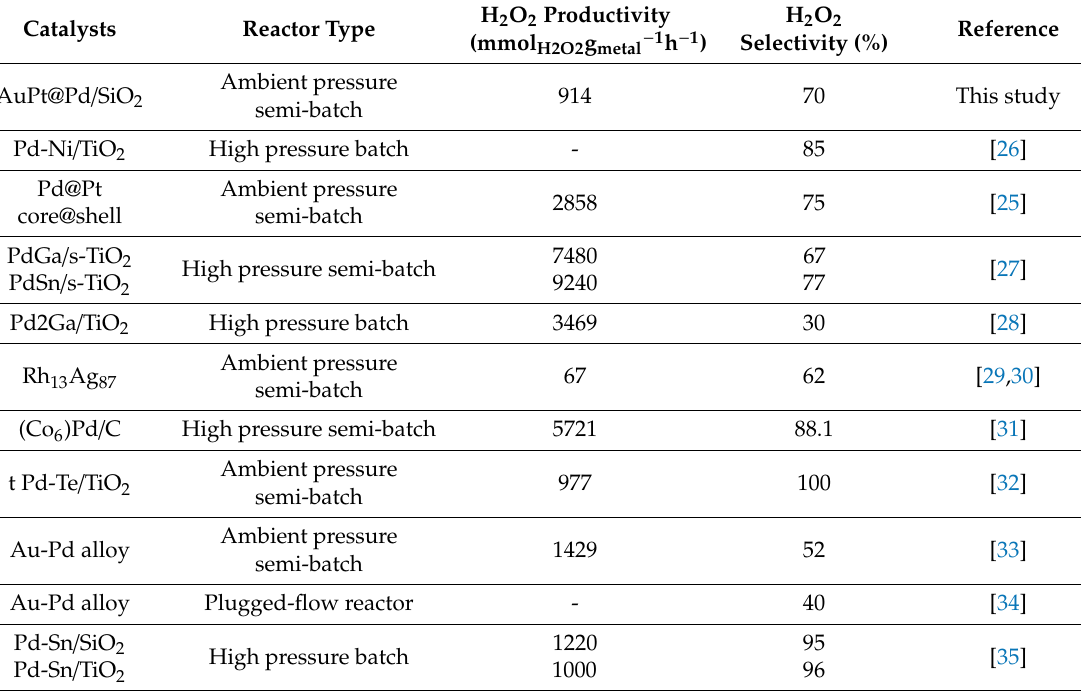
Table 1. Comparison of catalytic activities towards H 2 O 2 over Pd based bimetallic